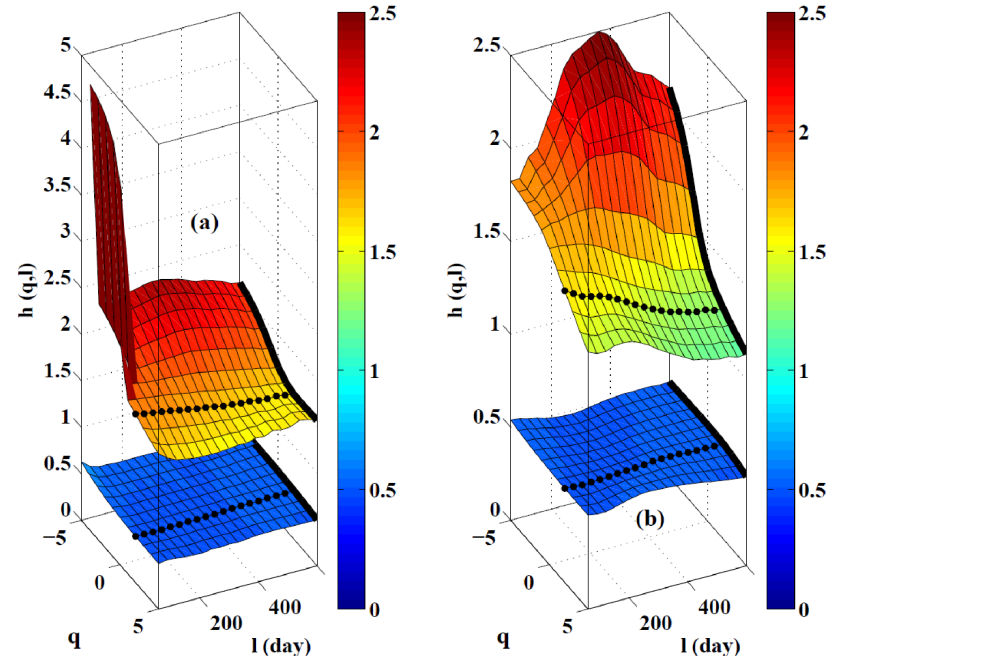
Figure 9. Multiscale multifractal analysis for (a) Well 1 groundwater levels and (b) Well 2 groundwater levels. The top figure (in red, yellow, and green) is for the original data and the bottom (in blue) is for the shuffled data. The thick black line indicates MF-DFA results for a given temporal scale, and the solid dots show the generalized Hurst exponents at q = 2 by DFA over different scales.